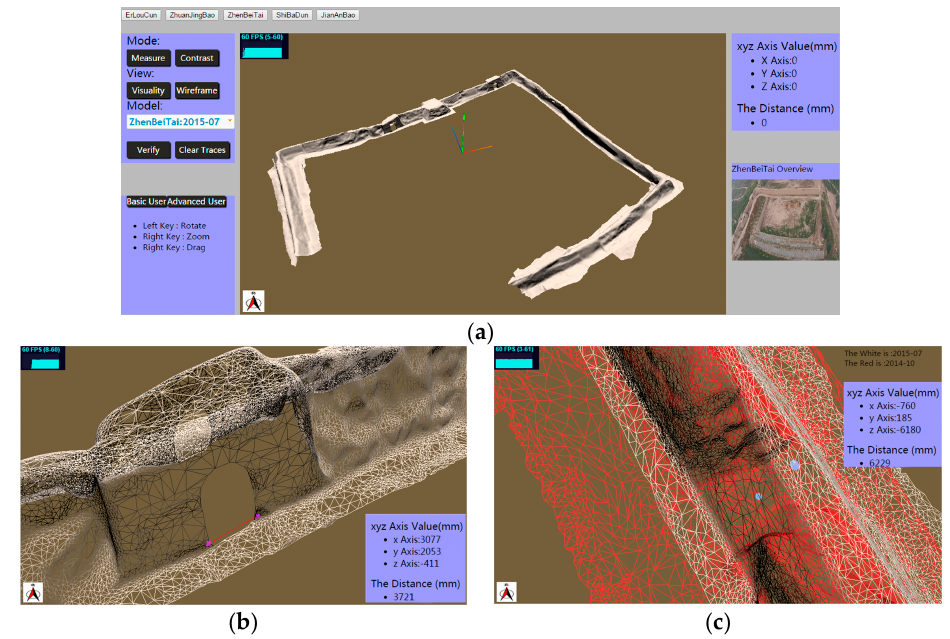
Figure 13. 3D model of Great Wall displayed on a web browser, ( a ) interface for the 3D visualization on the web; ( b ) distance measurement between two points of interest on the Zhenbei Tai (for a better view, the model is shown in grid mode); ( c ) comparison between two models of Zhenbei Tai built at different time periods (white for July 2015, red for October 2014).